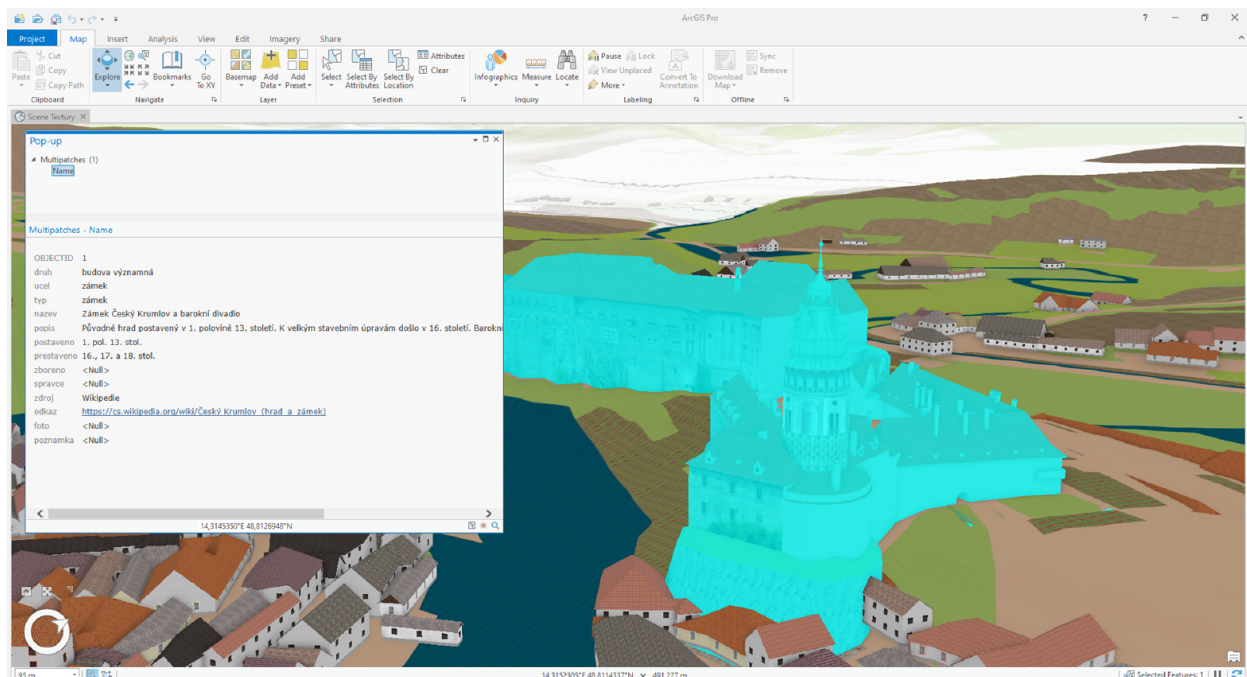
Figure 10. Both CAD and procedural models are queryable for attribute data (values of textual attributes are in Czech).